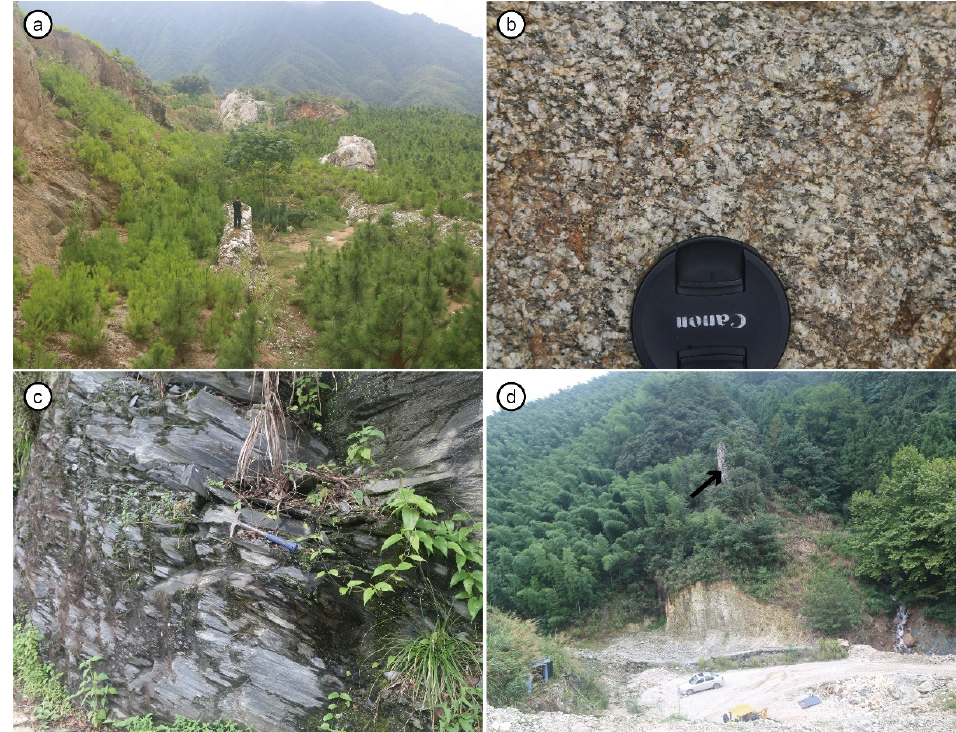
Figure 3. ( a ) Outcrop of the dyke-shaped Fujiashan-I quartz vein. Standing man in the middle for scale. View towards NE; ( b ) Gneissic biotite monzogranite of early Neoproterozoic in the Jiugongshan intrusion host to the Fujiashan-I quartz vein. Diameter of the camera cap is 7.7 cm; ( c ) Epimetamorphosed slate from the Lengjiaxi Group dated at 860–878 Ma. Geological hammer for scale; ( d ) Outcrop of the Yipanqiu quartz vein at the Zimudong locality with an active quarry in the foreground. Black arrow indicates the nearly vertical quartz vein. Facing NE.